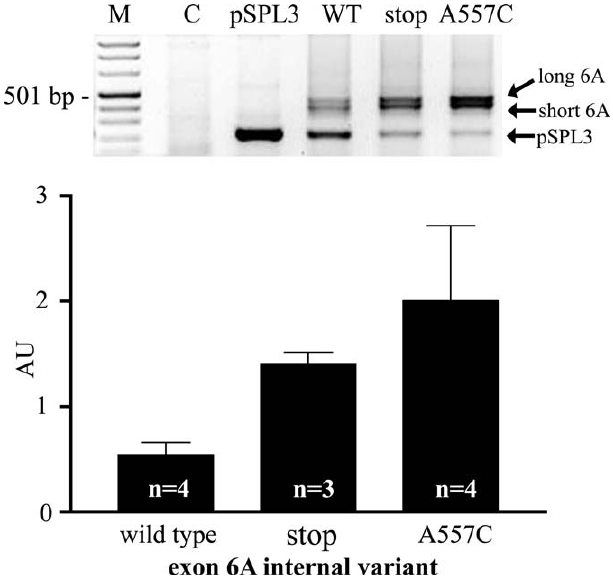
Figure 4. Mutation and Stop Codons Effect Exon 6A mRNA Expression Analysis of internal exon 6A inclusion in exon trap experiments showing that removal of the two stop codons (stop) or the presence of the A557C mutation significantly increases inclusion of the internal exon 6A variants. Upper image The expression of the terminal and internal variants was analyzed after transfection in COS7 cells and RT-PCR of pSPL3 constructs containing the wild-type (WT) exon 6A (along with 150 bp 5 9 and 3 9 : see Figure 2) or exon 6A after removal of the two stop codons (stop) or the introduction of the A557C mutation. Lower histogram: Densitometric quantification (in arbitrary units, AU) of internal exon 6A variants RT-PCR results (both short and long variant together) of three or four independent experiments, as indicated in the columns. Results are expressed as mean 6 SEM. p ¼ 0.0294 (Kruskall-Wallis test). Results suggest that removal of the stop codons or a mutation in the SRp55 site reduces NMD of the internal exon 6A transcripts.